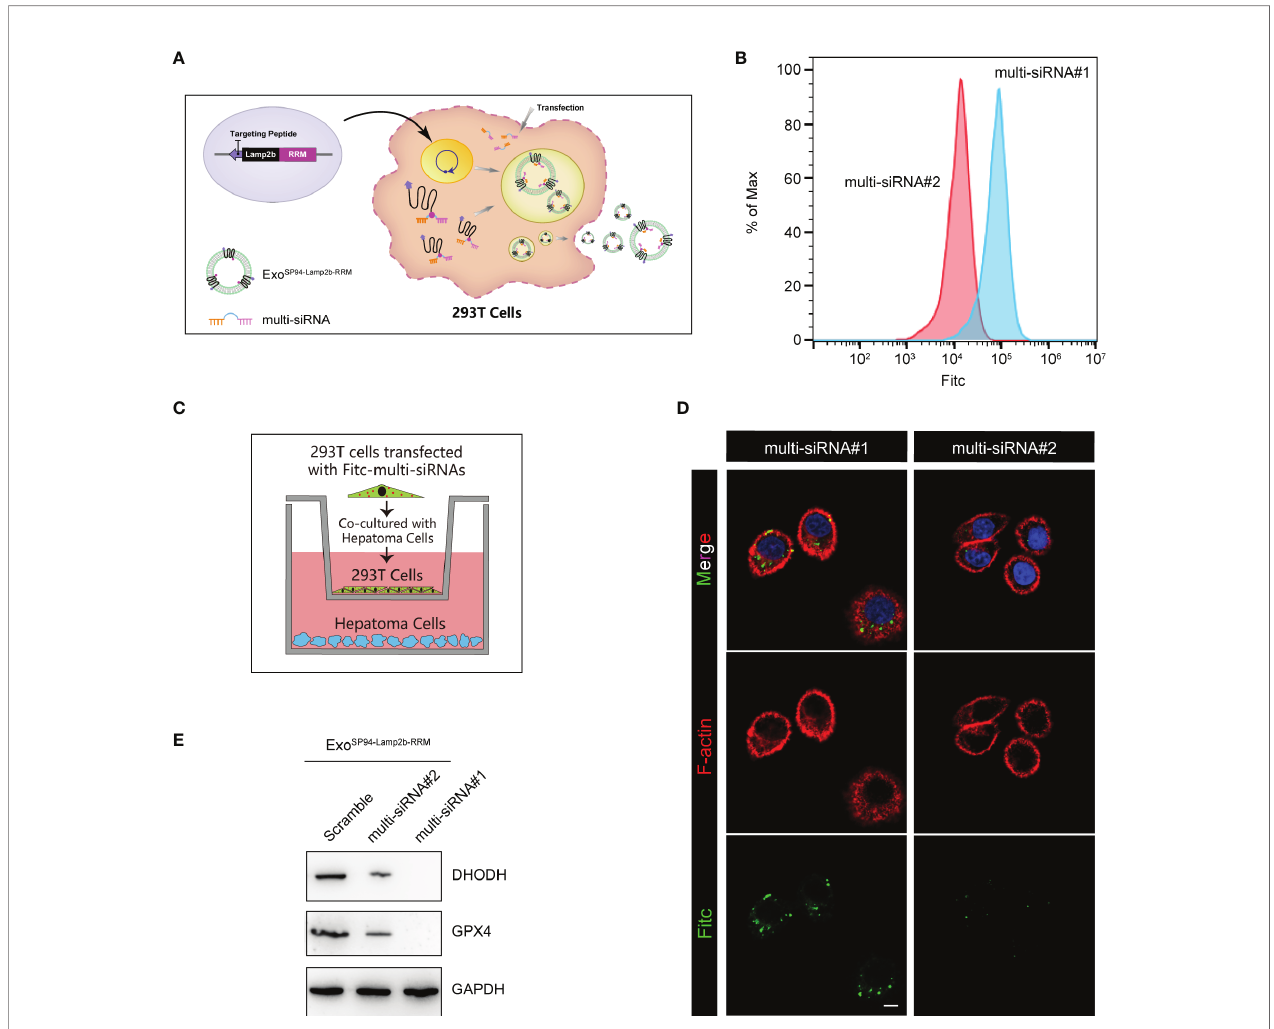
FIGURE 4 | Ef fi cient therapeutic cargo encapsulation into engineered exosomes expressing SP94-Lamp2b-RRM fusion protein. (A) Schematic diagram of the process of multi-siRNA encapsulation into exosomes via the SP94-Lamp2b-RRM fusion protein in HEK-293T cells. The SP94-Lamp2b-RRM fusion protein recruits multi-siRNA containing the sequence “ AUUGCAC ” to exosomes via RNA-RRM recognition. (B) HEK-293T cells transiently transfected with FITC-tagged multi- siRNA#1 or FITC-tagged multi-siRNA#2. Then, exosomes were collected for the fl ow cytometry assay (multi-siRNA#1, contains si-GPX4#1, si-DHODH#1 and the RRM binding sequence; multi-siRNA#2, contains si-GPX4#1 and si-DHODH#1 without the RRM binding sequence). (C, D) HEK-293T cells transiently transfected with FITC-tagged multi-siRNAs were cocultured with HepG-2 cells for 24 h. (C) Schematic illustration of HepG-2 and HEK-293T cell coculturing. (D) Representative confocal images of FITC (green) and F-actin (red) staining in HepG-2 cells. The nuclei were counterstained with DAPI (blue) (scale bar, 10 µm). (E) HepG-2 cells were treated with functionalized exosomes derived from HEK-293 T cells and containing SP94-Lamp2b-RRM, and Western blot assays were conducted to detect GPX4 and DHODH expression in HepG-2 cells. Scramble: 1*10 6 HEK-293T cells were treated with the same amount of scramble siRNA; multi-siRNA#2: 1*10 6 HEK-293T cells were treated with the same amount of multi-siRNA#2; multi-siRNA#1: 1*10 6 HEK-293T cells were treated with the same amount of multi-siRNA#1. After 24 h, the exosomes were collected and added to HepG-2